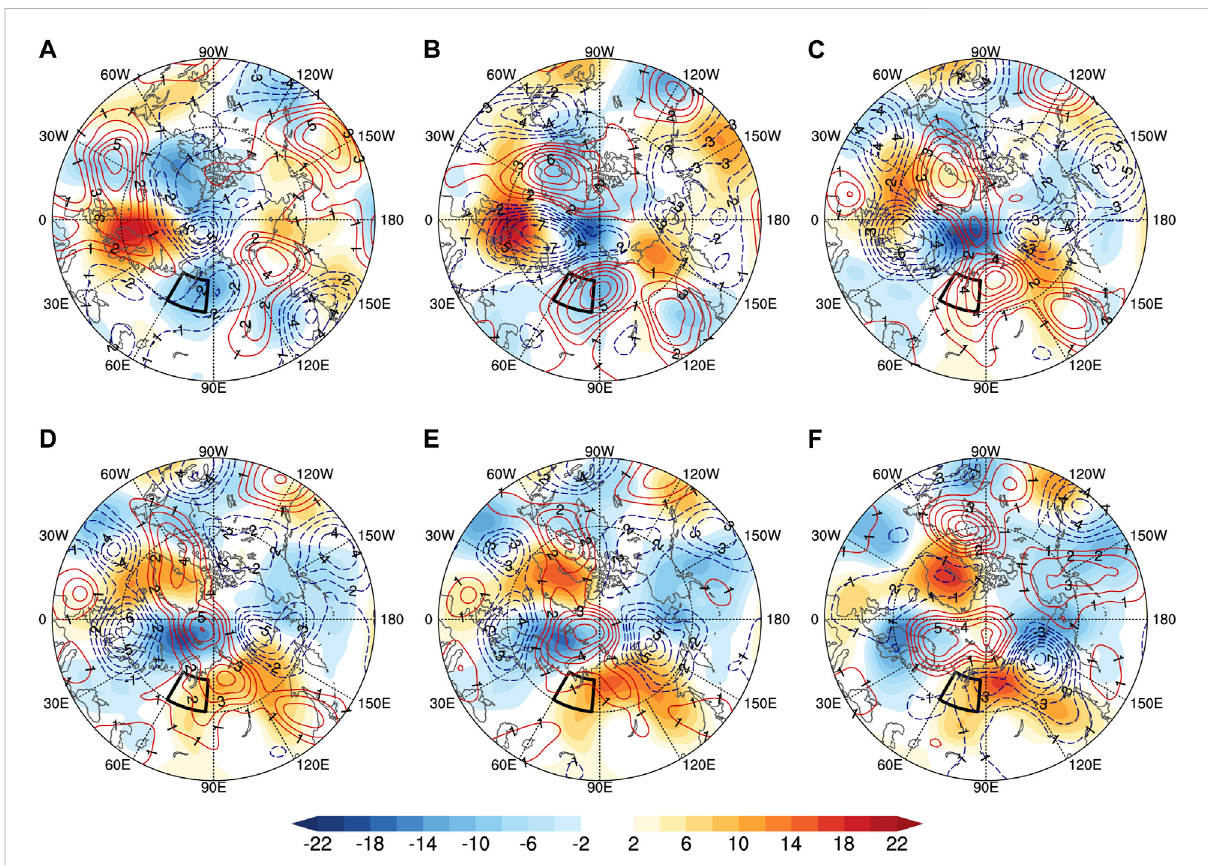
FIGURE 15 Quasi-biweekly-scalegeopotentialheightanomaly(shading)anditstendency(contour)fromday-10today0during theMeiyuonsetperiodin 2011 (A – F) (unit: gpm; black box: the mid-high-latitude key region; the latitude of the outermost line is 40 °